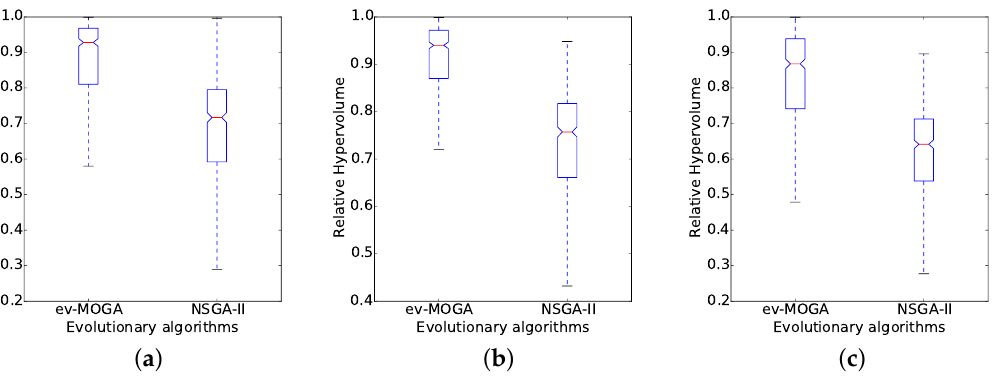
Figure 7. Relative hypervolume computed by Epsilon-Variable Multi-Objective Genetic Algorithm (ev-MOGA) and Non-dominated Sorting Genetic Algorithm version II (NSGA-II) for each green energy profile. ( a ) morning profile ( g 1 ); ( b ) midday profile ( g 2 ); and ( c ) night profile ( g 3